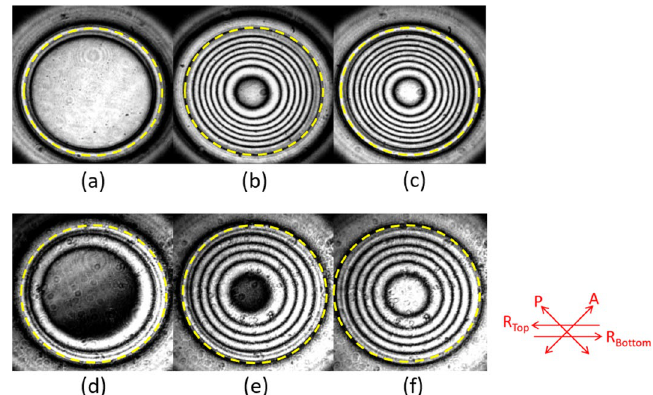
Figure 2. Interference fringes of the pristine HLC lens addressed at ( a ) 30 V, ( b ) 80 V, and ( c ) 100 V; interference fringes of the BR composite-doped HLC lens addressed at ( d ) 30 V, ( e ) 70 V, and ( f ) 80 V. The yellow dashed circle indicates the AH diameter; P and A indicate the transmission axes of polarizer and analyzer, respectively; R Top and R Bottom indicate the rubbing directions on the surfaces of the top and bottom substrates,